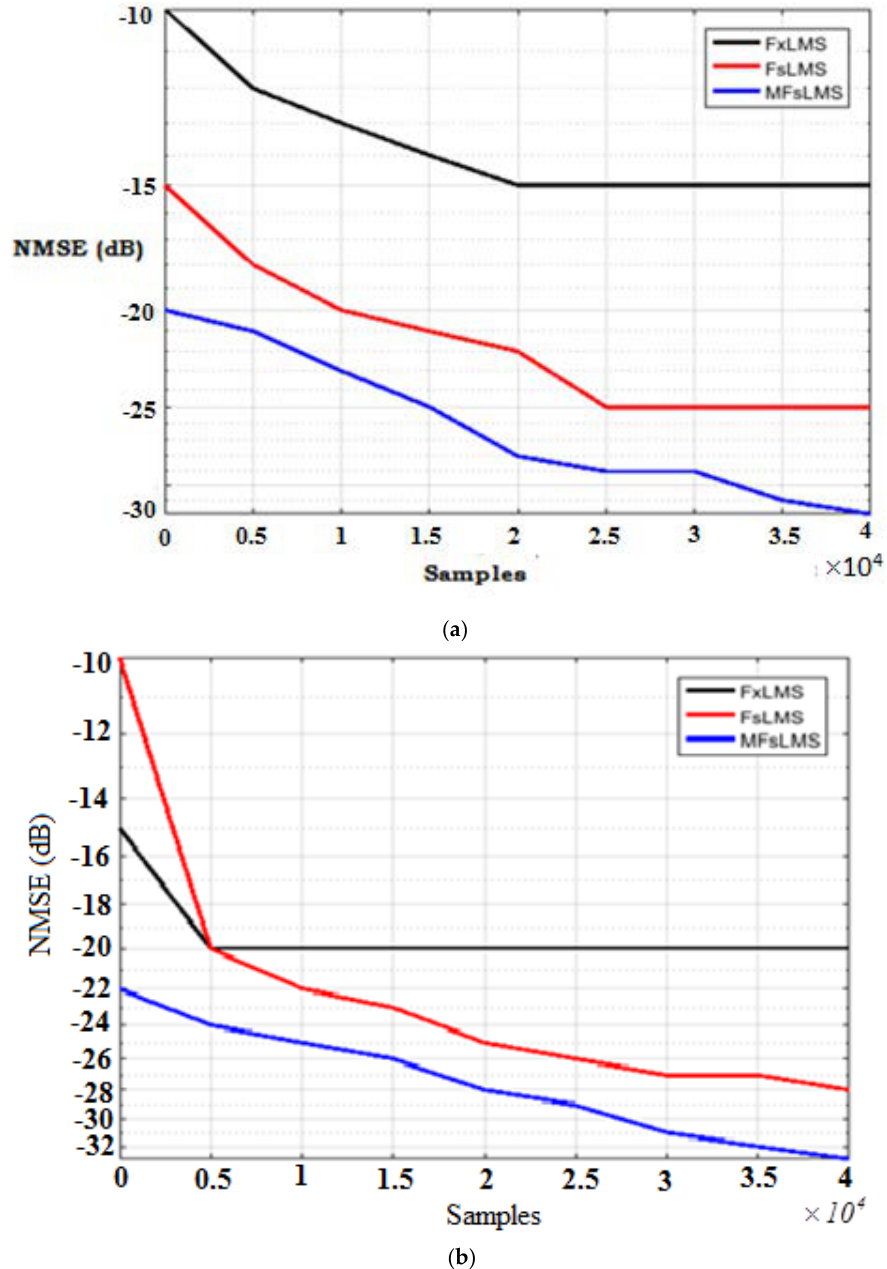
Figure 10. Performance evaluation of proposed method in terms of NMSE ( a ) Case 1; ( b ) Case 2.